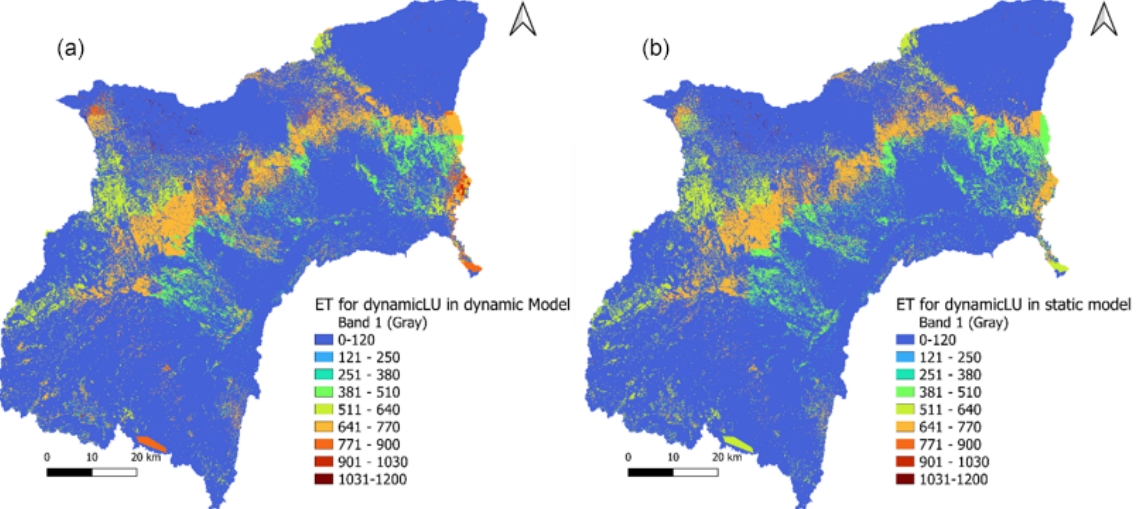
Figure 6. Spatial distribution of ET from dynamic land use for both (a) dynamic and (b) static SWAT + models.